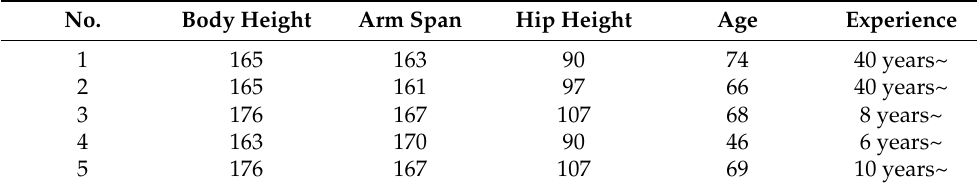
Table 1. Details of the Experimental Subjects.